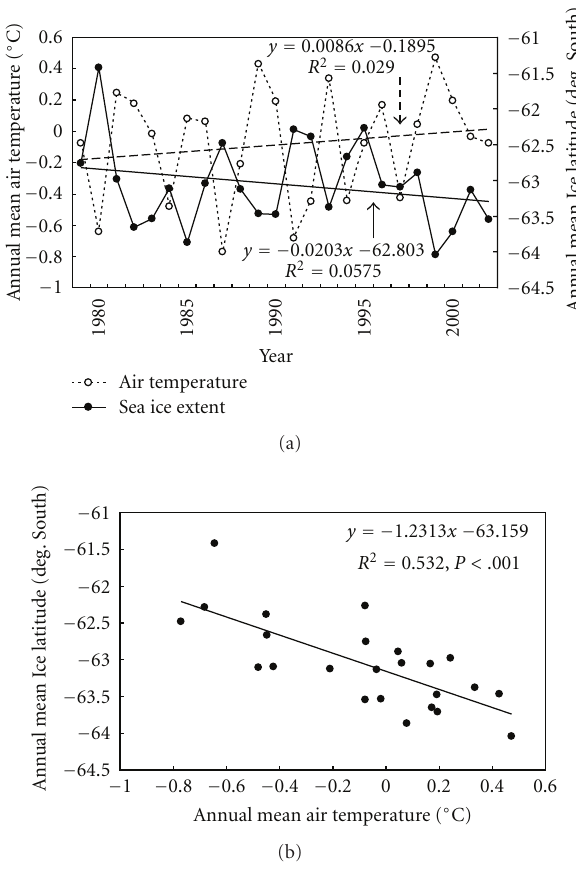
Figure 12: Time series of the annual mean air temperature and annual mean sea ice extent (a) and a linear correlation between two time series (b). Air temperature data were from South Georgia, and sea-ice extent was averaged for the region from 20 to 80 ◦ W.